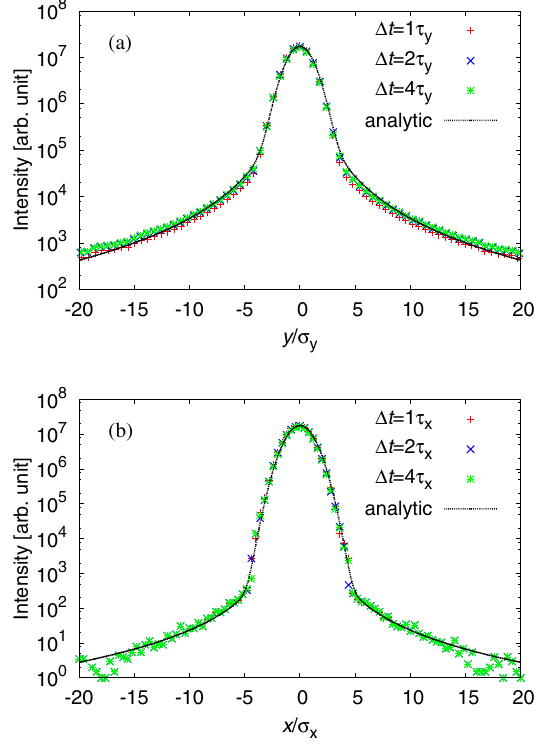
FIG. 5. Dependence of vertical (a) and horizontal (b) beam profiles on vacuum